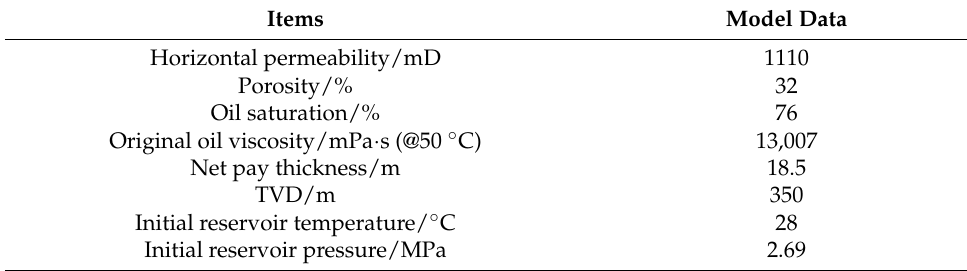
Table 2. Parameters of typical numerical simulation